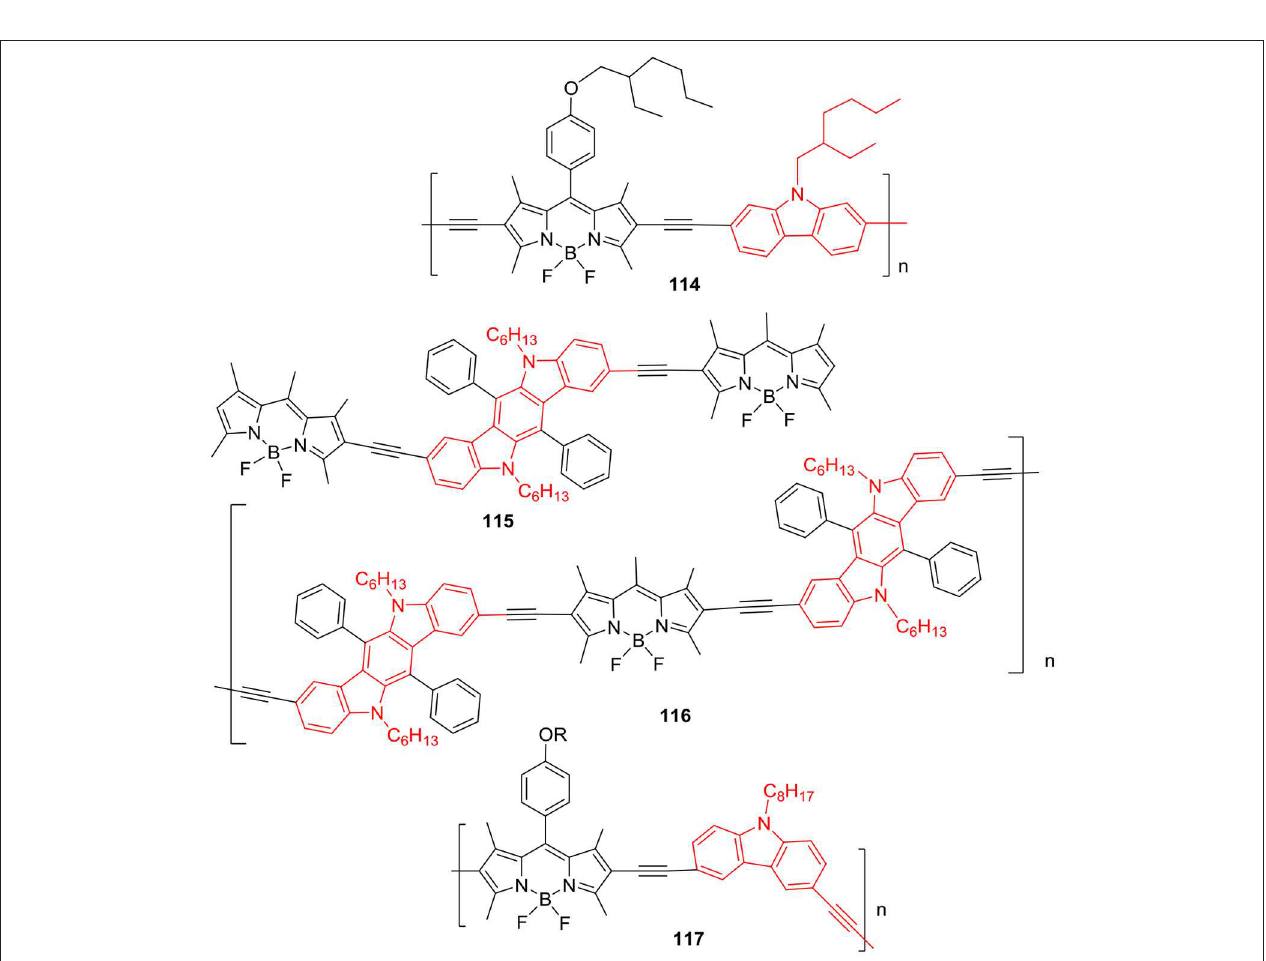
CHART 18 | Carbazole-BODIPY based polymers.